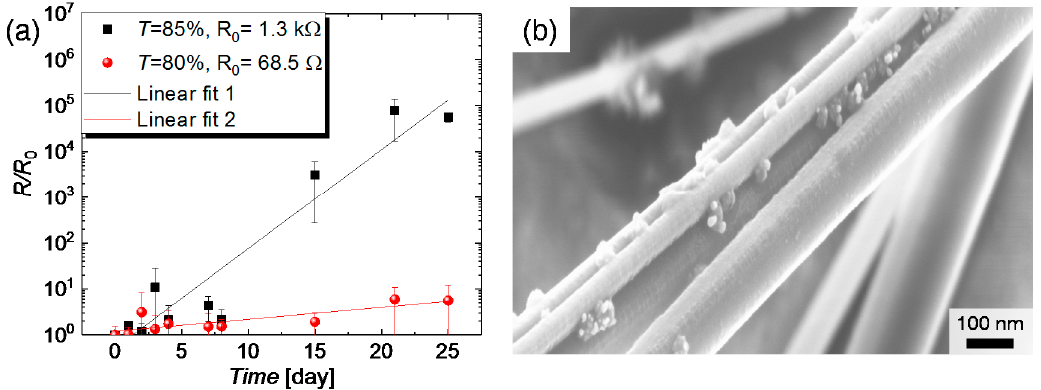
Figure 4. ( a ) Normalized increase in resistance R / R 0 of two CuNW films with different transmittances exposed to ambient conditions as a function of the time; ( b ) FESEM-image of CuNWs exposed to ambient conditions for more than 25 days.